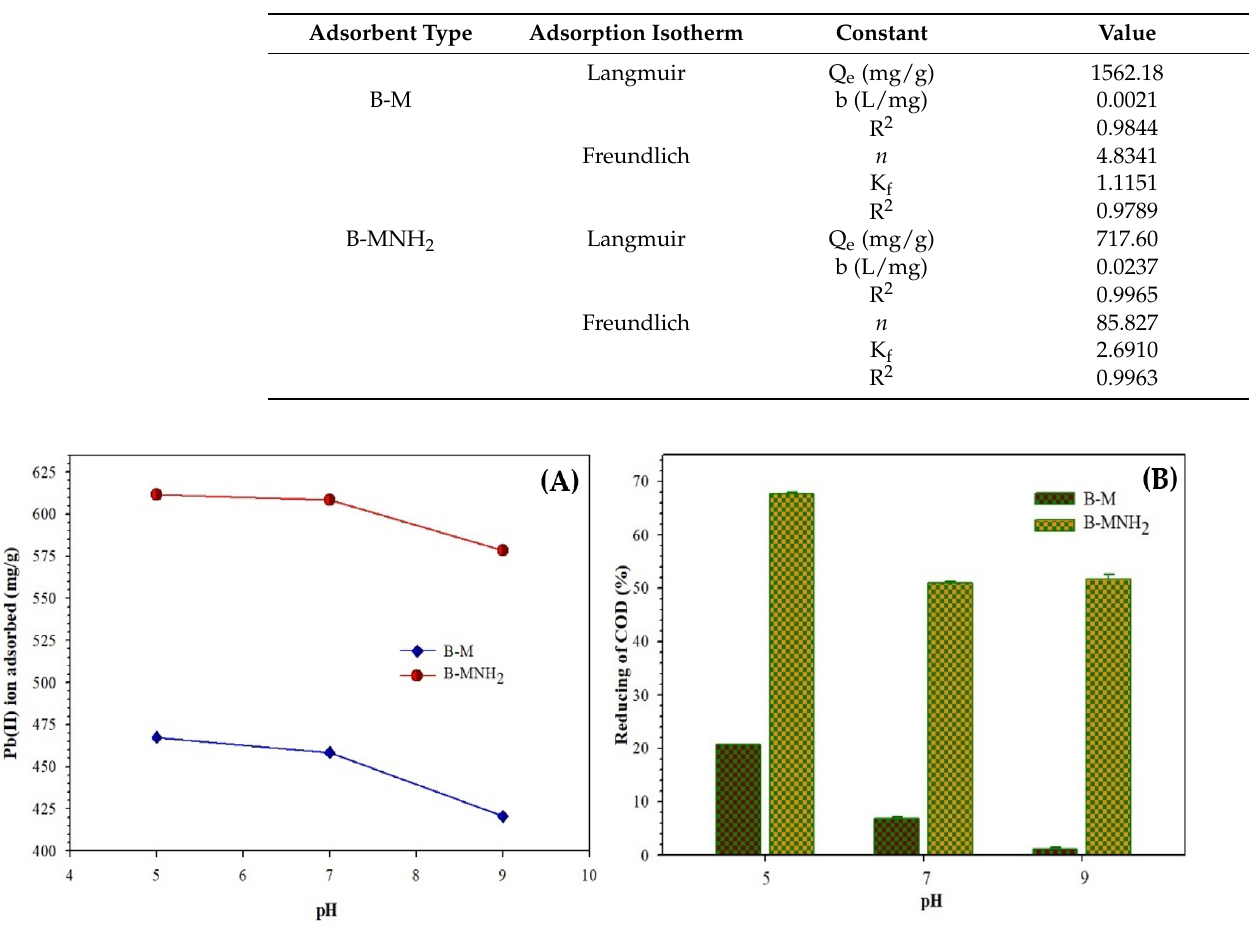
Table 3. Pb(II) ion adsorption isotherm parameters using B-M and B-MNH 2 .